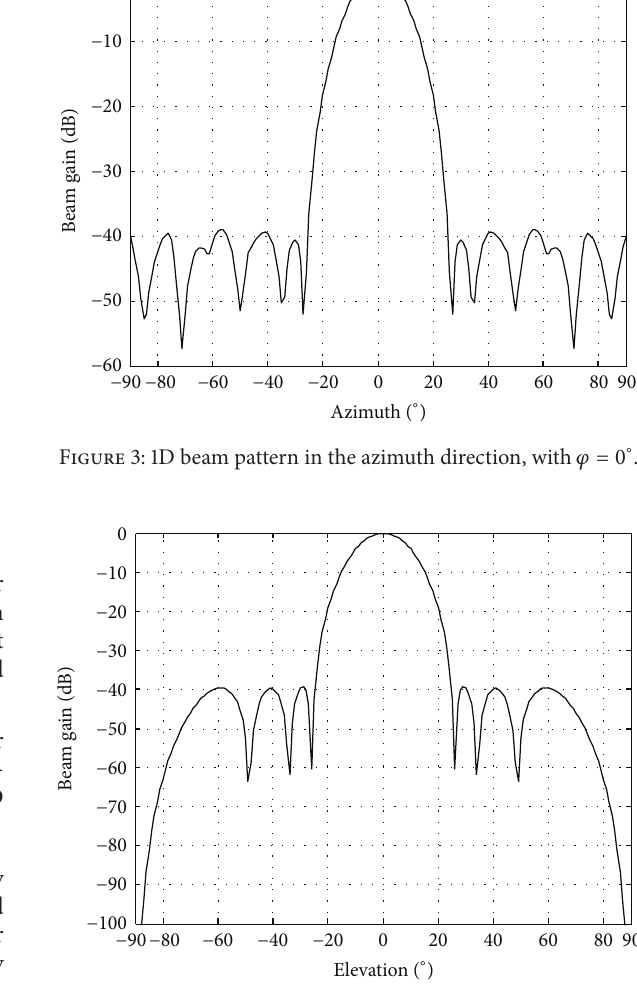
Figure 4: 1D beam pattern in the elevation direction, with 𝜃 = 0 ∘